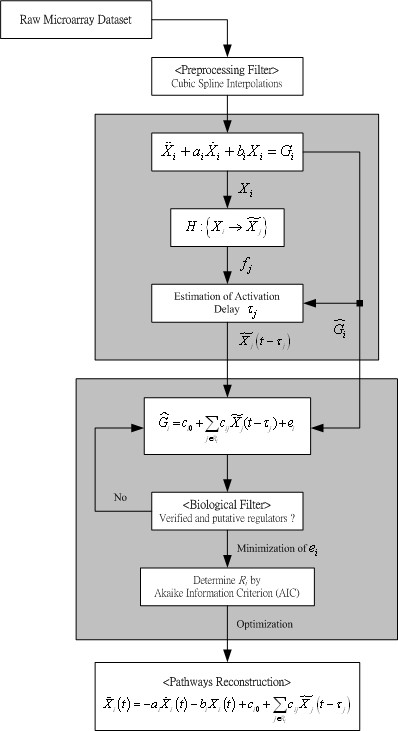
Illustration of the overall flowchart of the pathway inference algorithm.